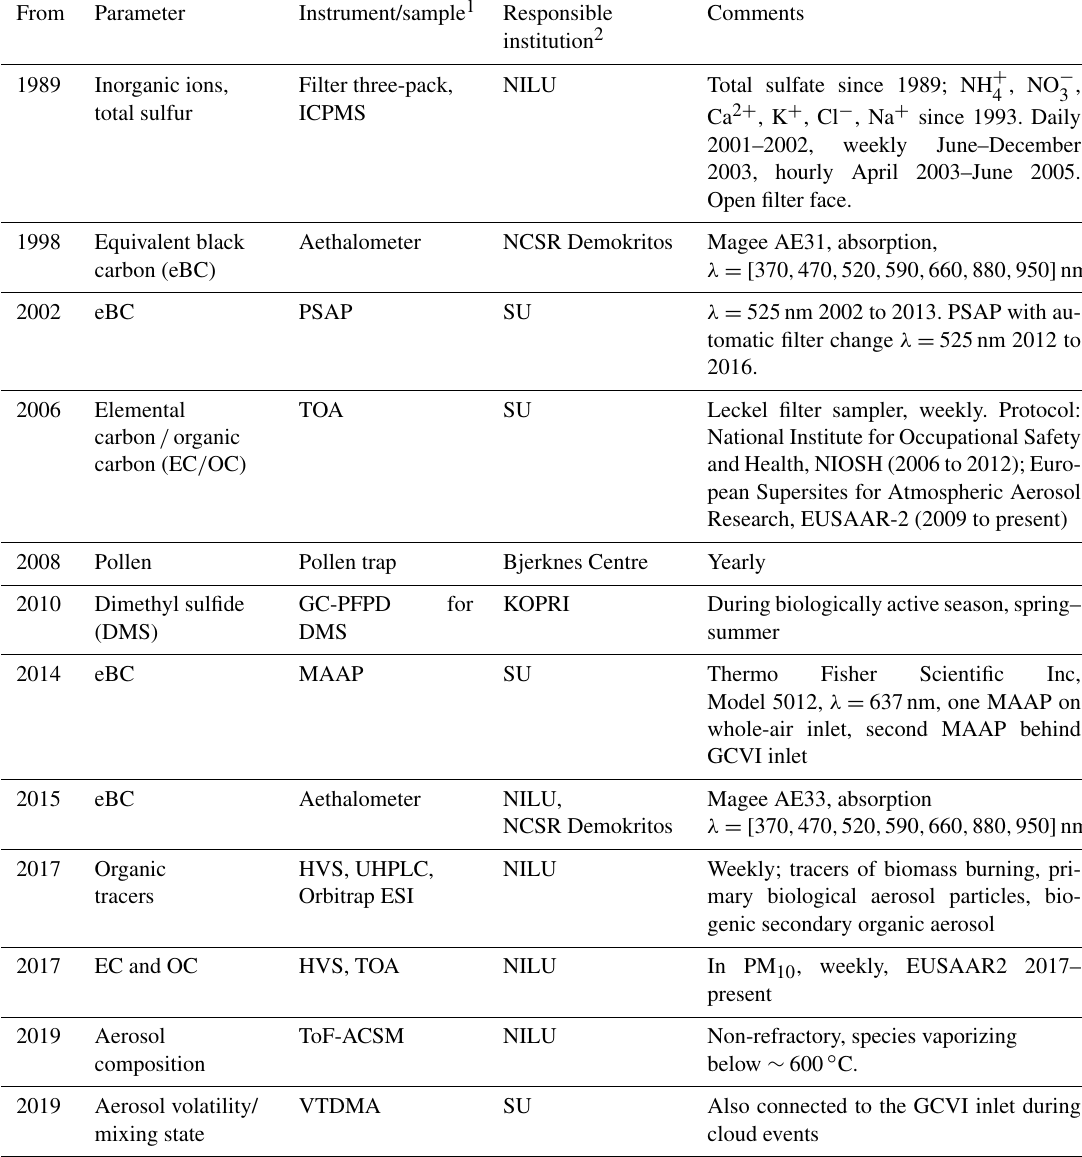
Table 1. Aerosol composition and inorganic species measurements at the Zeppelin Observatory, listed chronologically by measurement starting year. See table footnotes for full lists of